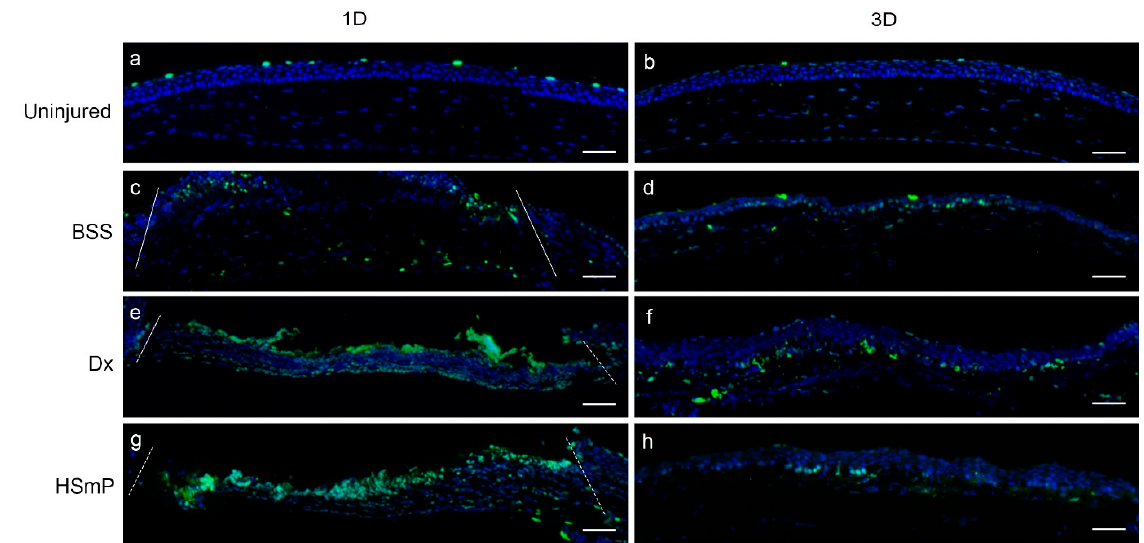
Figure 3. TUNEL-positive profiles (in green) in the laser-ablated region (1 day and 3 days after surgery). Uninjured corneas ( a , b ) showed a low number of apoptotic cells restricted to the outermost layer of the epithelium. One day after injury, the BSS-treated group ( c ) showed a higher number of apoptotic cells compared to Dx ( e ) or HSmP ( g ). Number of TUNEL+ cells was greatly reduced at 72 h in all groups ( d , f , h ). Dashed lines mark the border of the initial injury in the 1 D series of images (scale bars: 50 µ m).